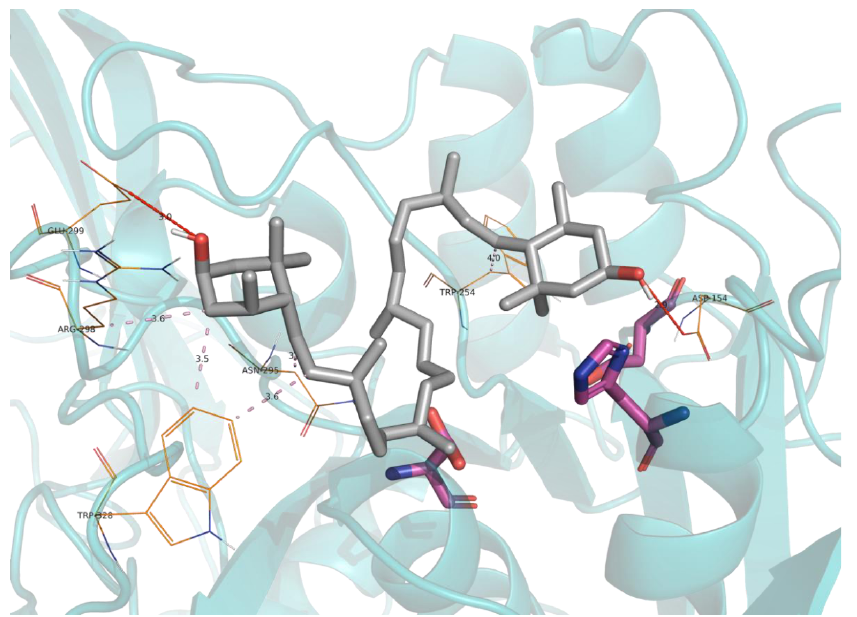
Figure 4. Obtained docking pose for Zeaxanthin into the active site of furin. The carbon skeleton of Zeaxanthin is depicted in grey, while the carbon skeleton of catalytic triad residues is depicted in pink. Main interaction residues are shown in lines represented in orange. Hydrogen interactions are represented by red dashed lines, while hydrophobic interactions are shown by purple dashed lines. The secondary structure of the protein is shown in cartoon representation.